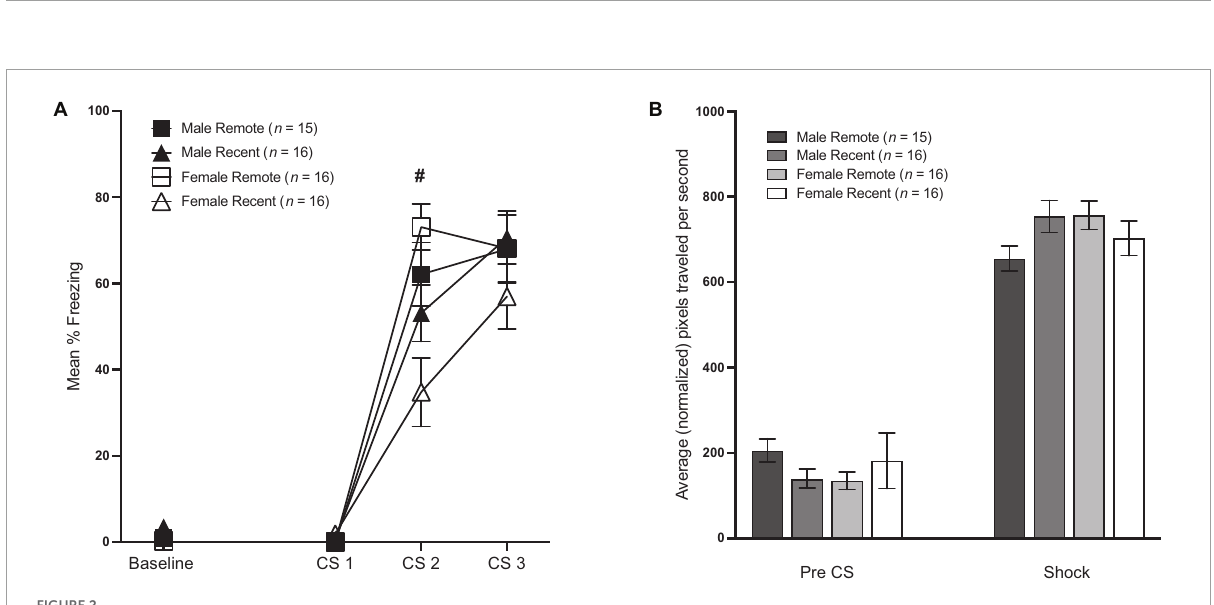
FIGURE2 (A) Mean percent freezing ( ± SEM) during conditioning. Baseline represents the 64-s baseline period preceding the first tone. CS 1–3 = the 10-s tones that preceded shock. There was a small but significant difference in freezing during the baseline period, such that Remote groups froze less than Recent groups. During conditioning, Recent groups froze significantly less than Remote groups during CS 2 (# indicates a significant difference between Recent and Remote, p < 0.05), but there were no differences in freezing during CS 1 or CS 3 (see Section “Results” for